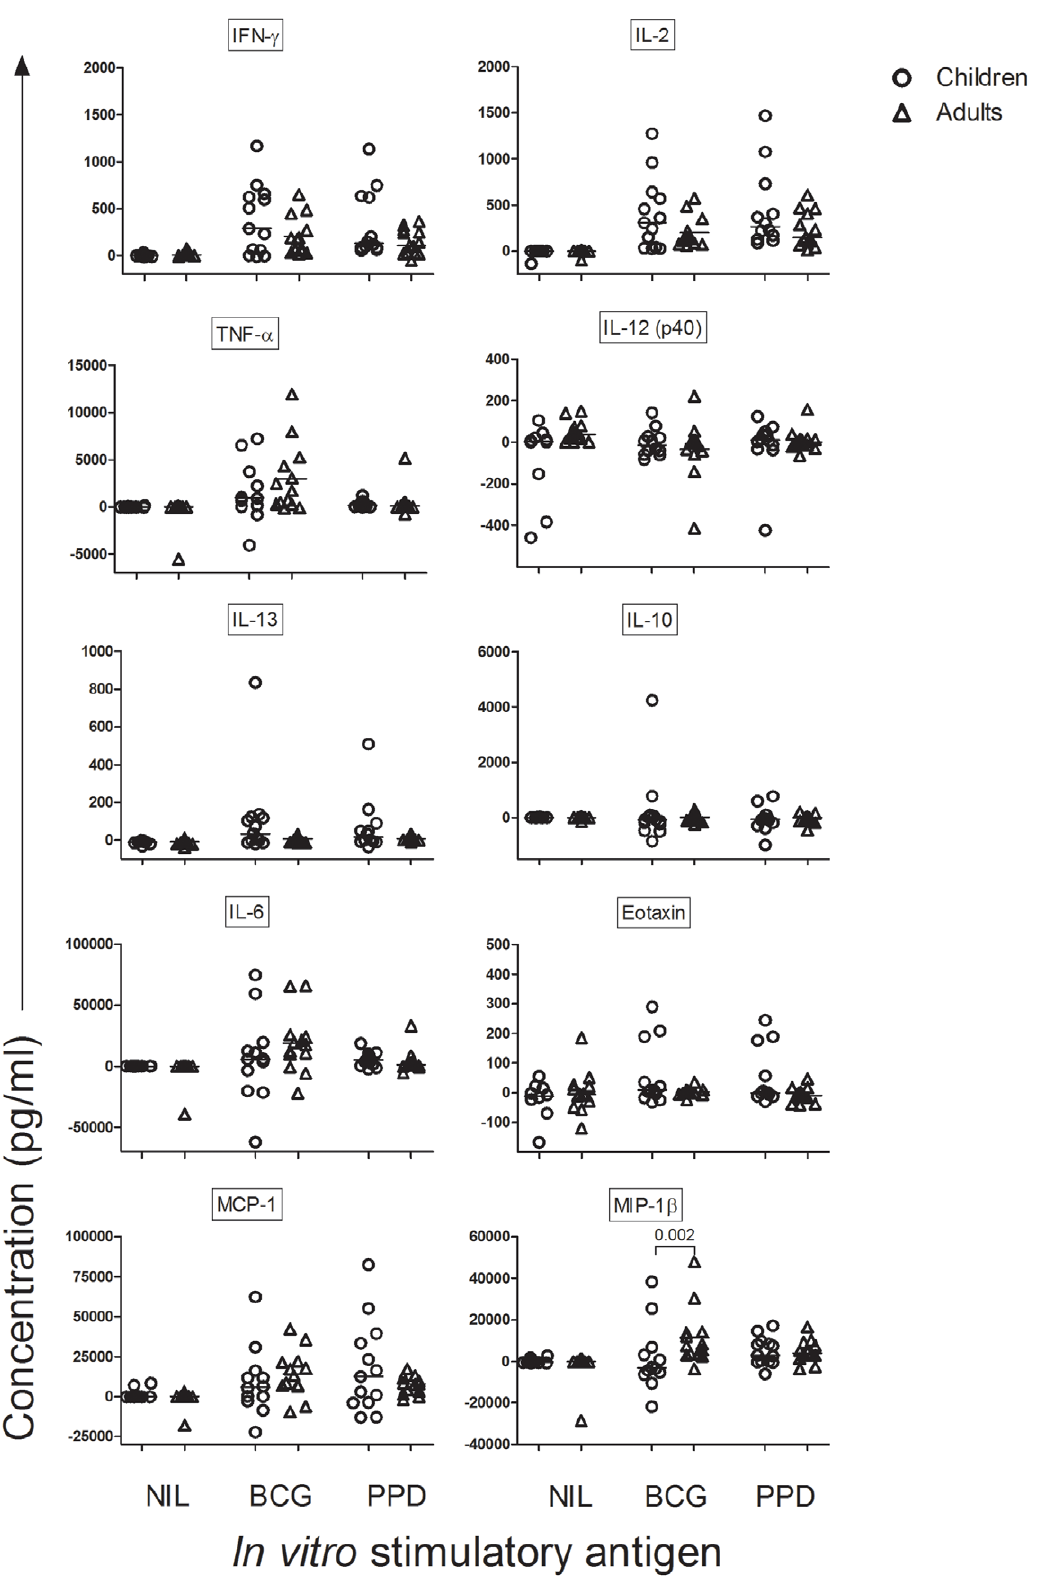
Figure 7. Comparison of the changes in cytokines/chemokines between 13 children (circles) and 13 adults (triangles). Concentrations were determined using xMAP technology following in vitro stimulation with the antigens BCG and PPD in samples taken before and 10 weeks after BCG immunisation. Statistical differences were analysed using a using a Mann-Whitney test and p-values , 0.05 are shown. Bars indicate medians.